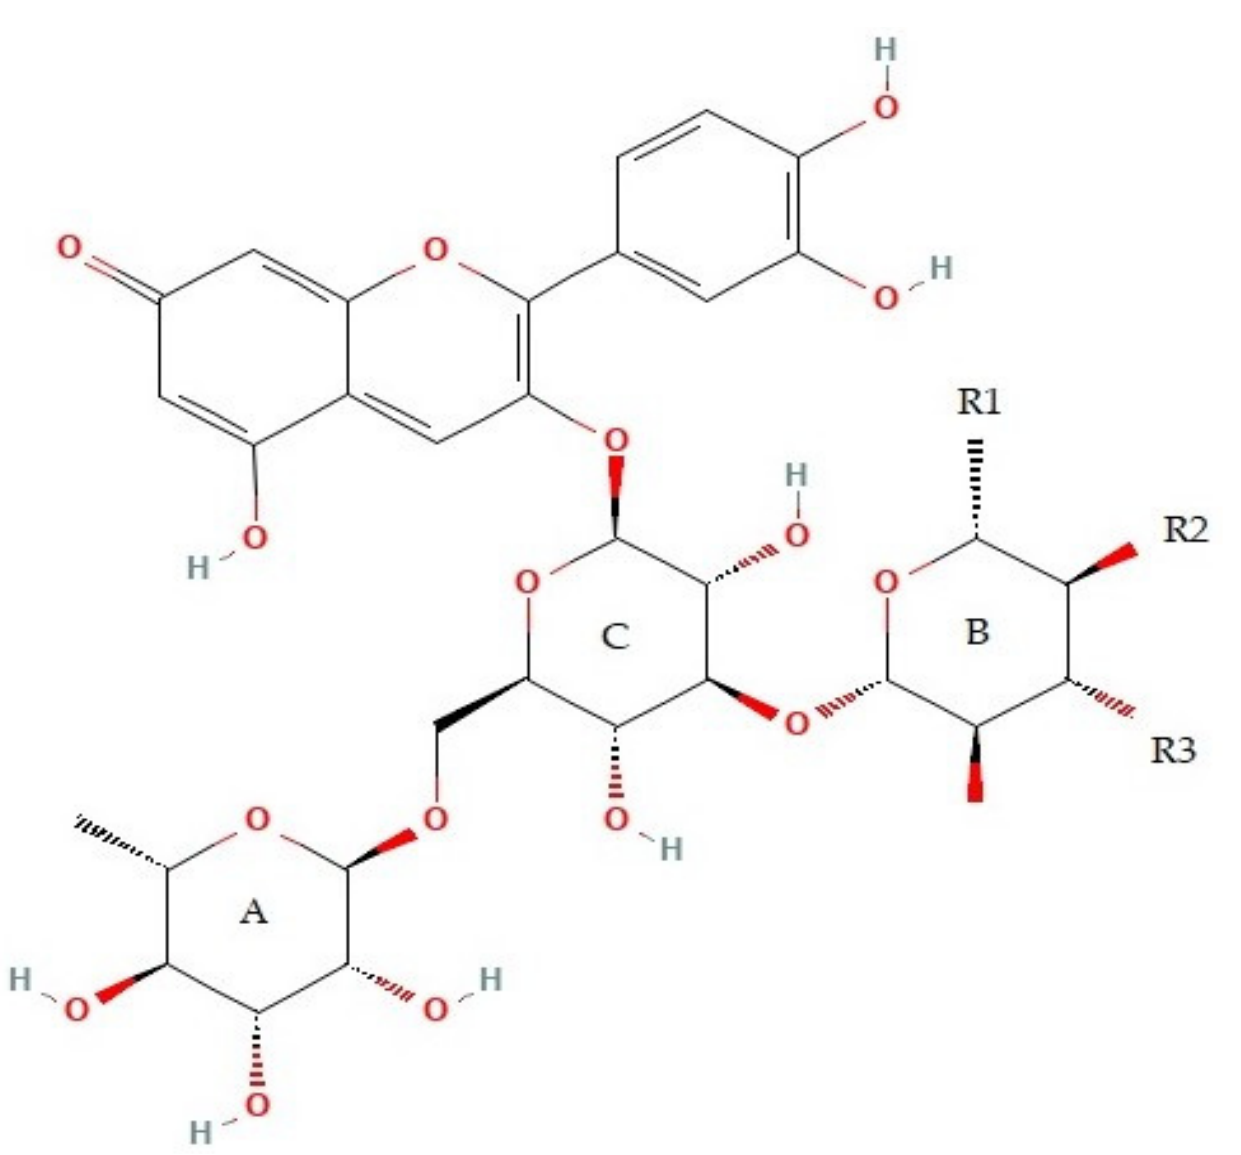
Figure 1. Chemical structure of anthocyanin. R1, R2 and R3 represent the -OH and -OMe groups in various anthocyanidins (PubChem).